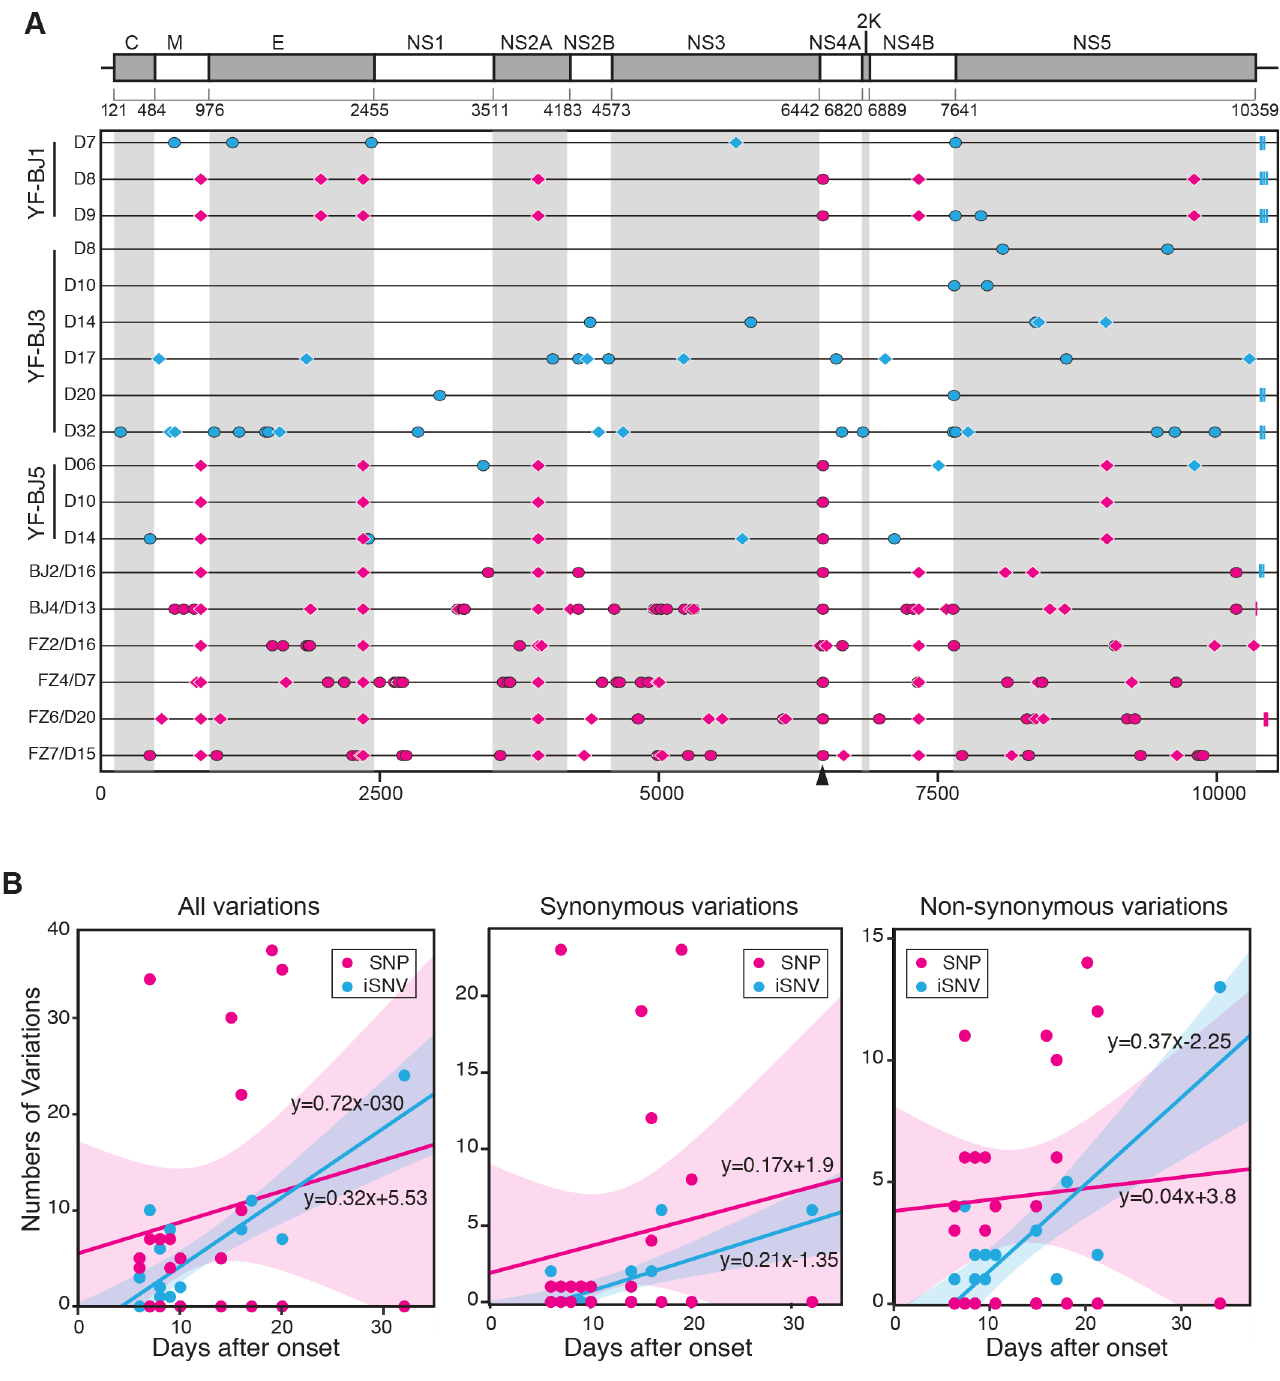
Fig 4. Genomic variations of Angola 2016 YFV and evolutionary model. (A) SNPs (in magenta) and iSNVs (in cyan) detected in Angola 2016 strains along the YFV genome. Non-synonymous variations are denoted by ovals, synonymous variations by diamonds, and variations in UTR by rectangles. Non-synonymous site at 6463 is denoted by arrowhead. YFV genome of patient YF-BJ1 at 7 days after the onset (YF-BJ1/7D) was used as the reference sequence (B) Linear regression of number of variations at all variations, synonymous and non-synonymous sites accumulated by days after onset. The smooth shadows denote the LOESS fit with 95% confidence